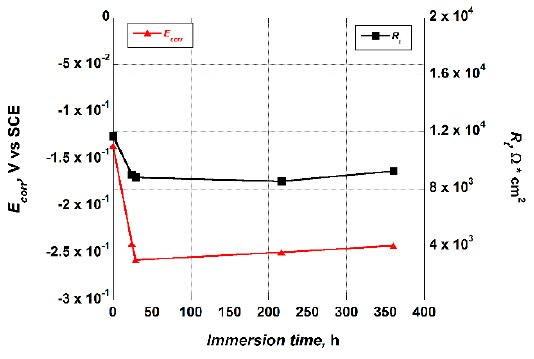
Figure 7. Trend of the E corr and R t values versus the immersion time in the Hank’s solution exhibited by the Ti_NTorg sample.